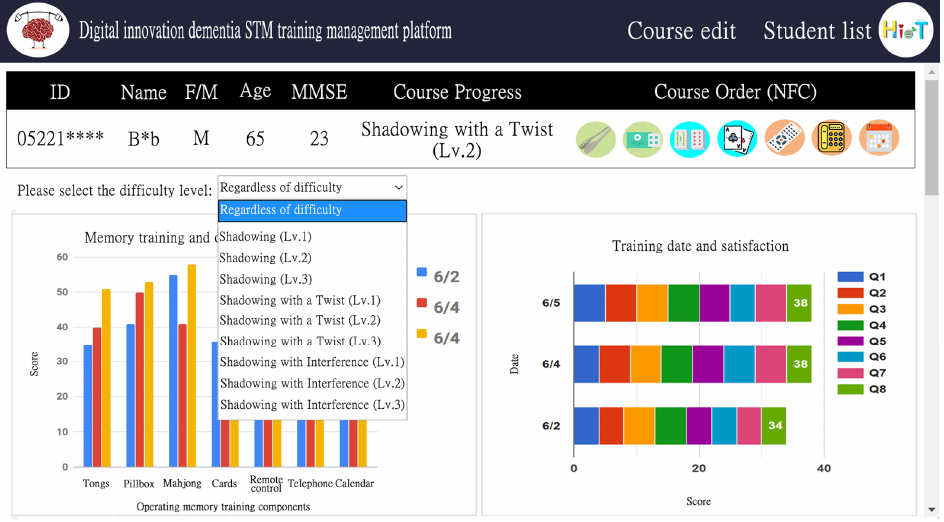
Figure 10. Statistical diagram interface of digital short-term memory cognitive training